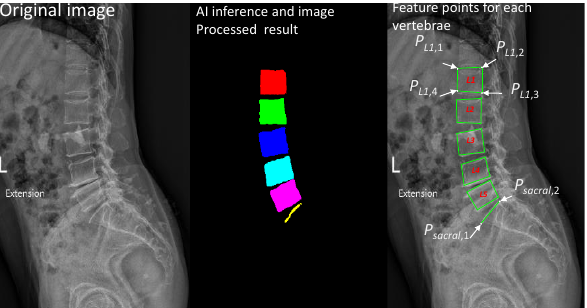
Figure 4. Original image ( left ), processed image ( middle ) with different colors to distinguish verte- brae from L 1 to S 1, and calculated feature points of each vertebra and sacrum ( right ).